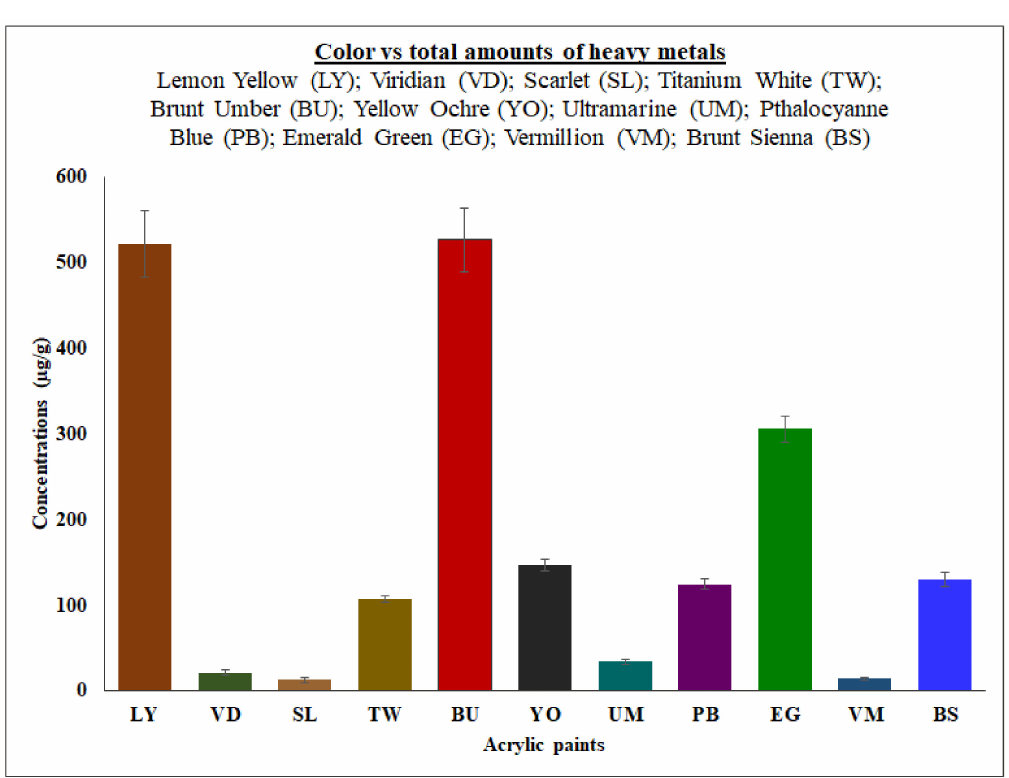
Figure 3. Acrylic color paints vs variation of heavy metal concentrations.